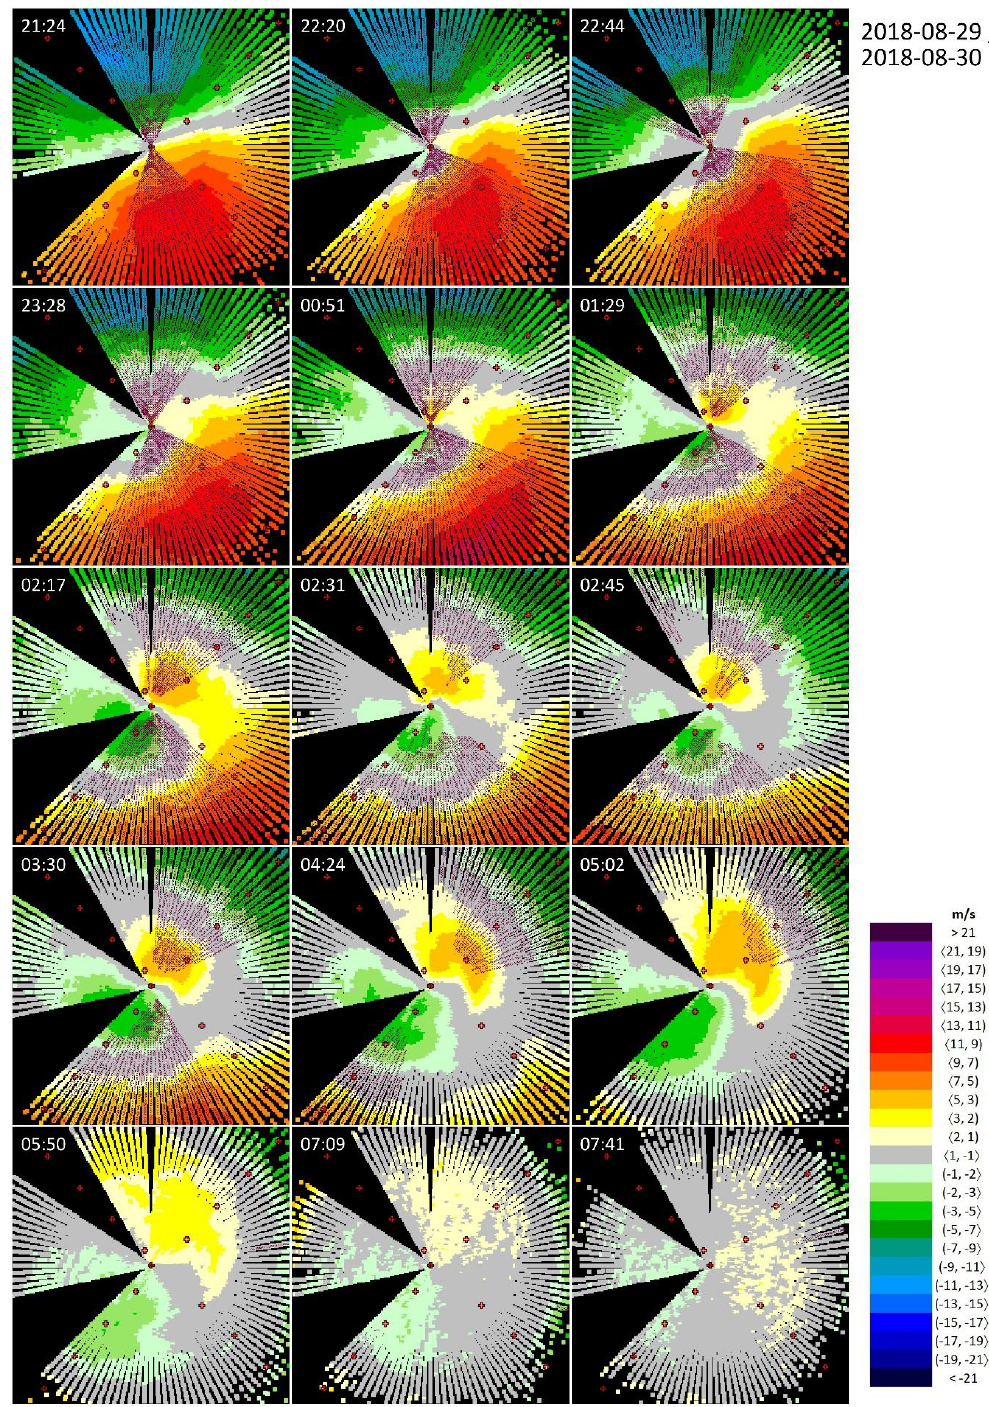
Figure 5. Wind shear on the boundary of two atmospheric layers from ~21 PM UTC on 29 August 2018 until ~8 AM UTC on 30 August 2018, seen by the lidar at the Bratislava Airport, located at the center of each figure. Wind blowing towards the lidar is defined as positive. The empty (full) pink circles indicate wind shear condition (microburst condition) according to the ICAO thresholds.